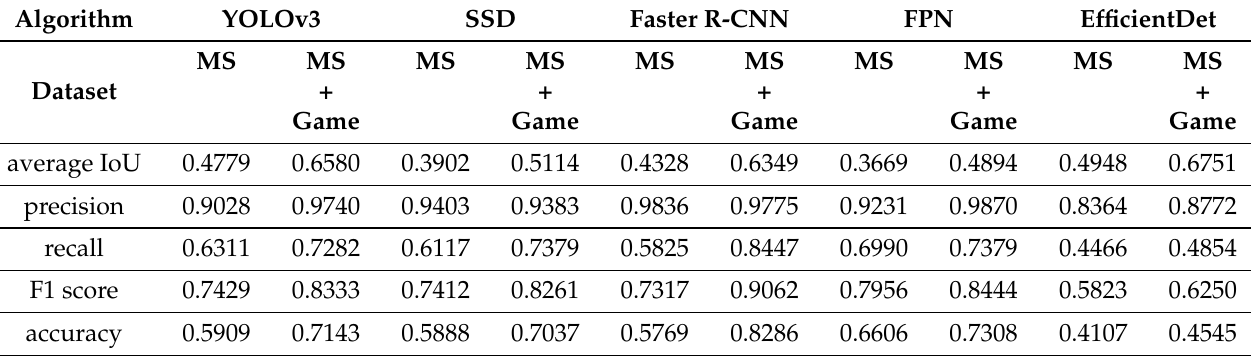
Table 7. The statistics. We compared the algorithms trained by MS COCO and retrained by MS COCO with game scenes for five object detection algorithms. Note that MS COCO is abbreviated as MS in the